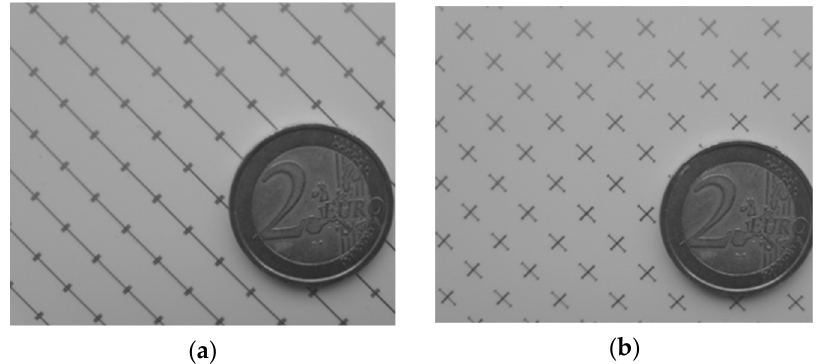
Figure 8. Manufactured prototype: ( a ) Top side; ( b ) bottom side.